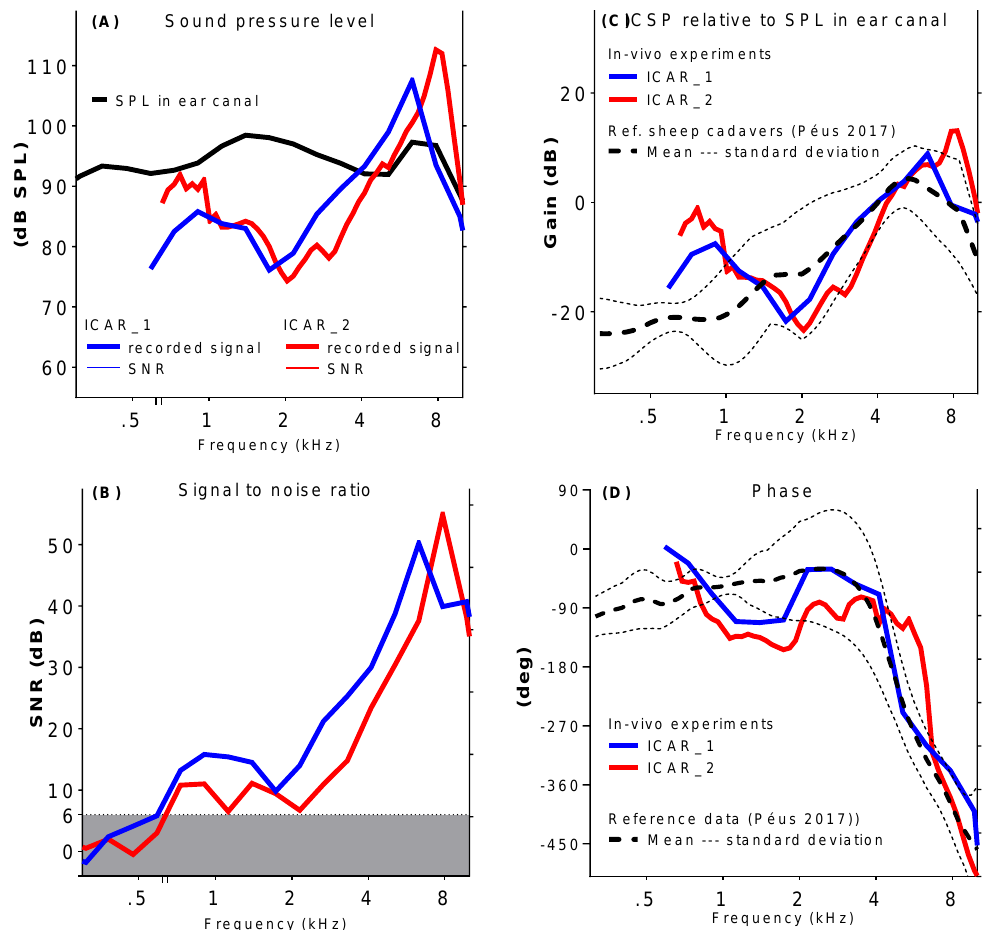
Figure 4. Acute sheep experiments (ICAR _1 blue lines; ICAR_2 red lines): ( A ) Intracochlear sound pressure level (solid lines) and corresponding sound pressure level in the ear canal (dashed line). ( B ) SNR (solid lines) shown as difference between ICSP ( A ) and noise measurements (dashed lines in Figure 3). The grey shaded area represents SNR < 6 dB. Recorded ICSP normalized by the measured sound pressure in the ear canal: magnitude ( C ) and phase ( D ).